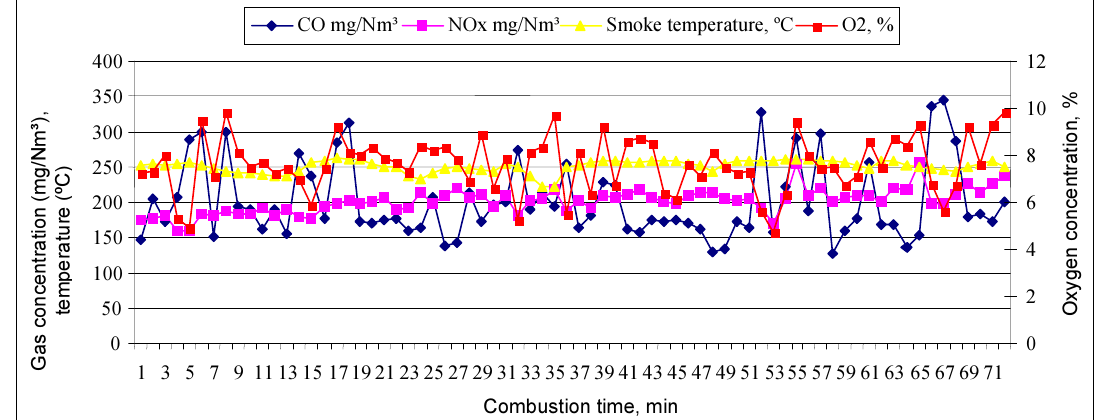
Fig. 1. Change of composition and temperature of smoke burning wood granules